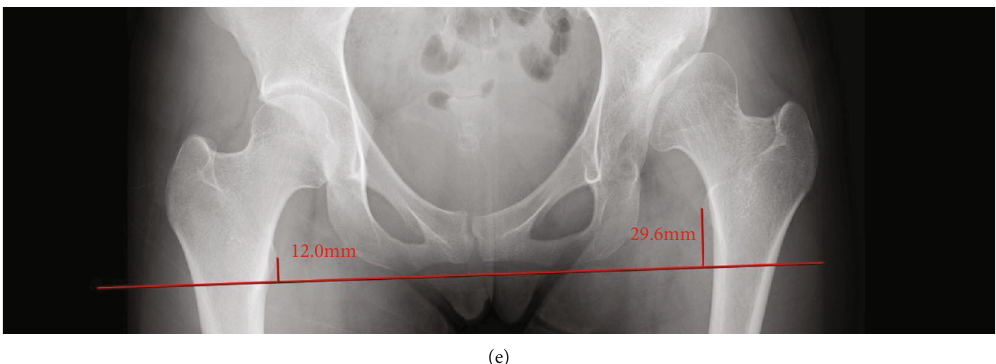
Figure 1: A 20-year-old woman with severe acetabular dysplasia. (a) Preoperative anteroposterior radiograph of the left hip joint, (b) preoperative CT coronal view, and (c) preoperative 3D-CT frontal view. Compatibility of the left hip joint was poor, and the femoral head of the superior acetabular coverage was insu ffi ciently covered. (d) The abduction radiograph of the left hip shows good compatibility with the left hip joint. (e) The distance of leg length discrepancy from the center of the lesser trochanter to the bottom of the ischial tuberosity was